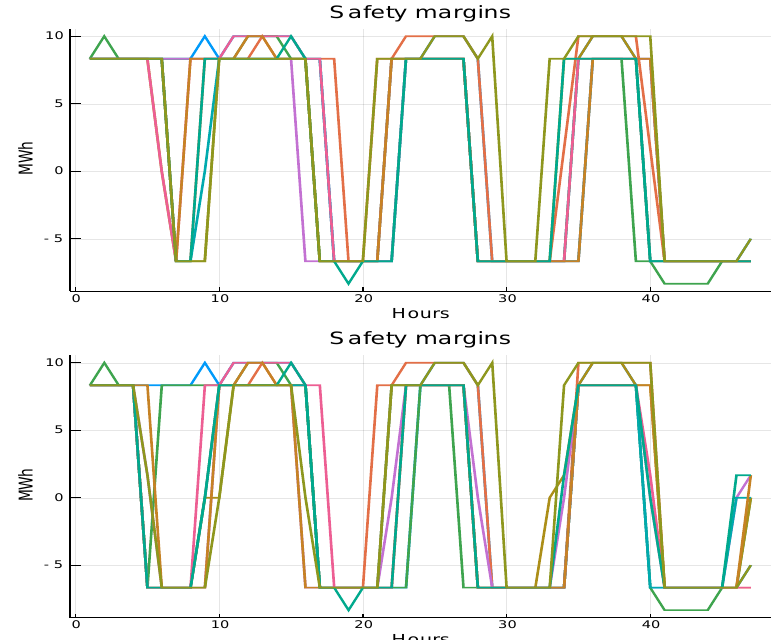
Figure 5. Safety margins based on the parameter values in Table 1, with η 1 = 100, η 2 = 15 ( upper plot ) and with η 1 = 0 ( lower plot ). Contrary to Figure 4, the price trajectories, shown in the lower panel of Figure 3, are not reported here to avoid a confusing overlapping with the safety margin plots.